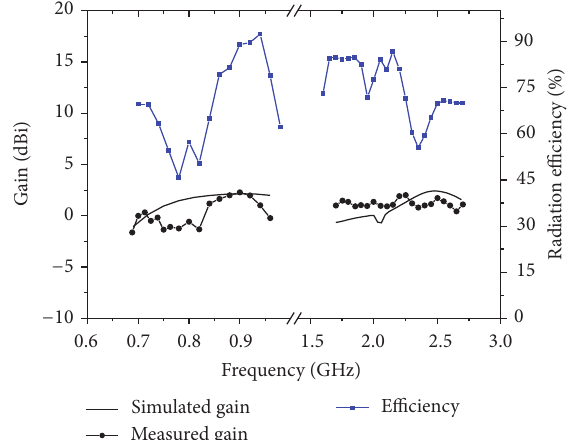
Figure 10: Antenna gain and radiation efficiency.